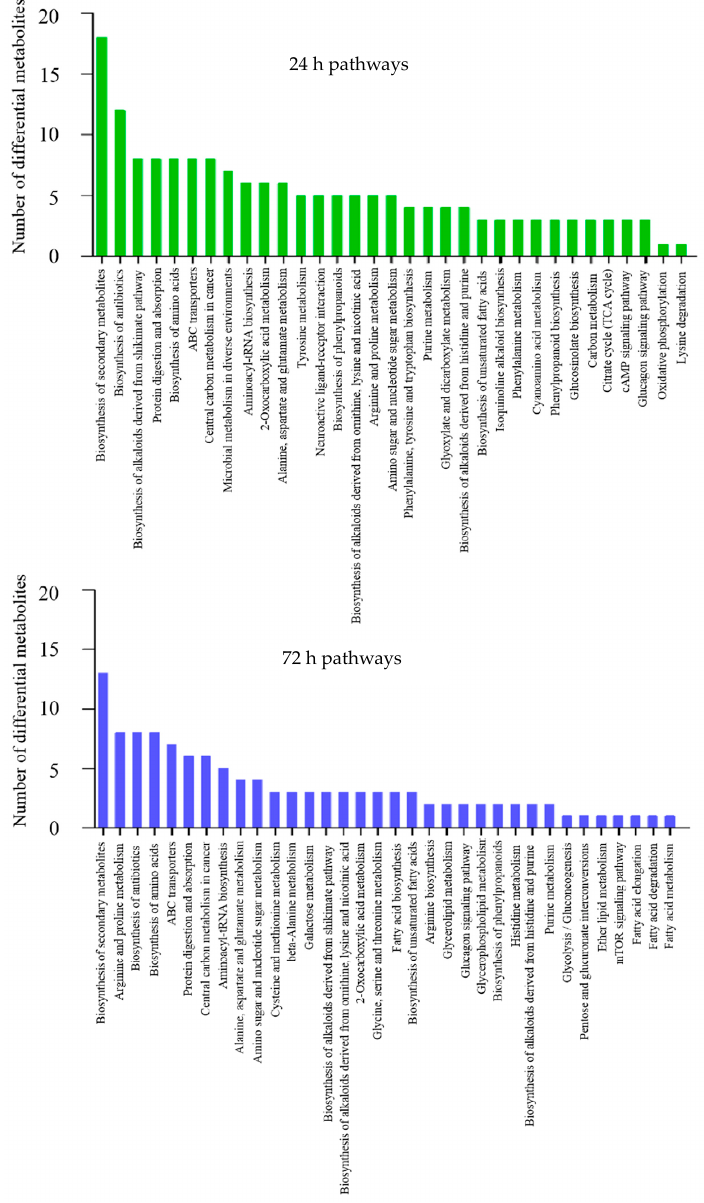
Figure 3. KEGG enrichment analysis for differential metabolites upon ISKNV infection.